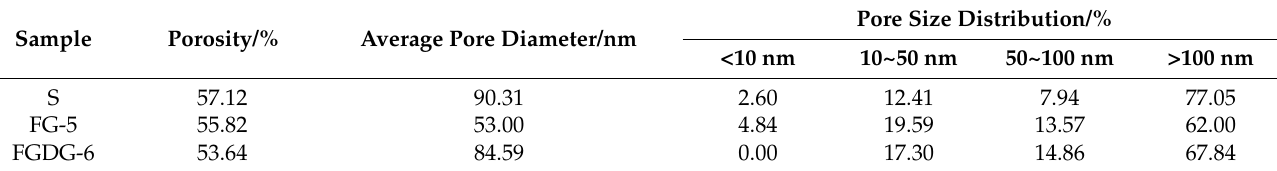
Table 5. Pore size distribution of samples at 28